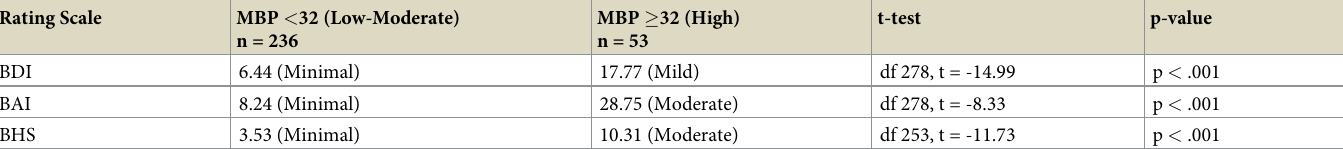
Table 4. Significant differences in clinical assessment symptom severity between subgroups of patients scoring above and below threshold for high psychological pain